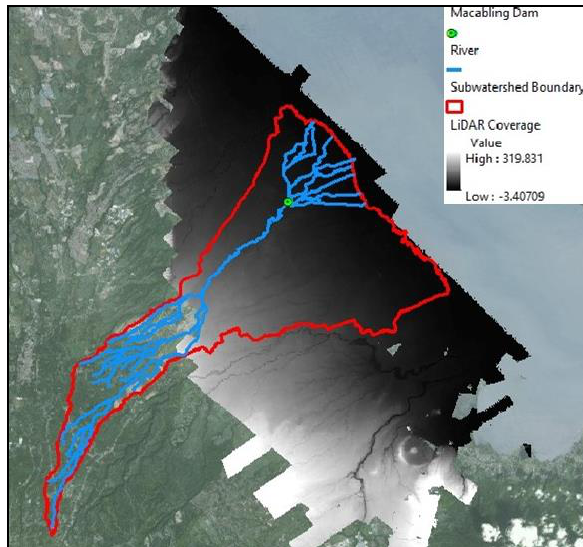
Figure 5. LiDAR data coverage in the downstream of the